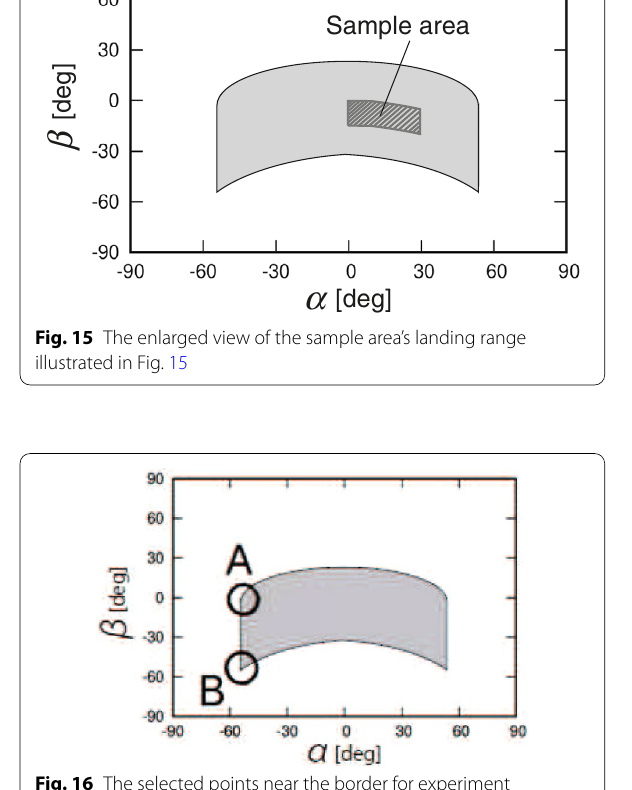
Fig. 16 The selected points near the border for experiment